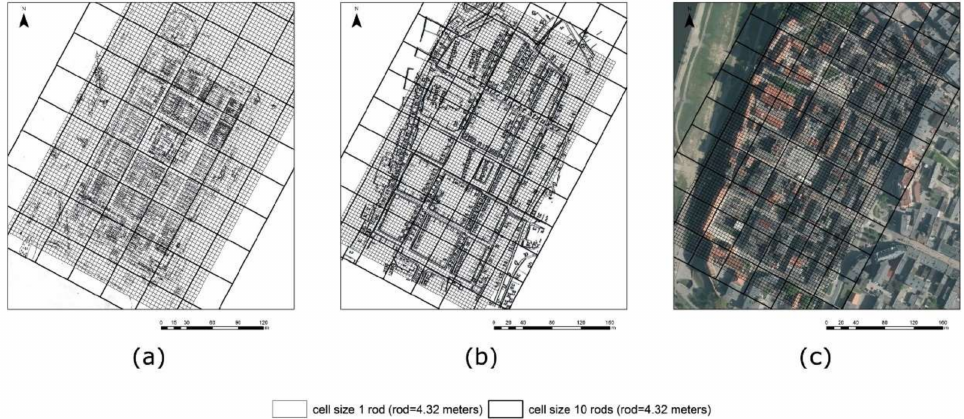
Figure 10. An example of the possibility of applying HGIS tools. Grid imposed on archival Grundriss der Stadt Graudenz Anno 1772 (Town plan) ( a ), Town plan (Grudzi ˛adz) from the year 1897 ( b ), and a contemporary orthophotomap ( c